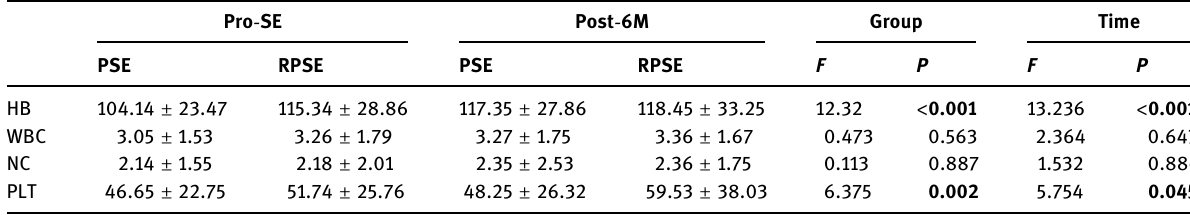
Table 5: Comparison of hematological index between PSE and RPSE Pro - SE Post - 6M Group